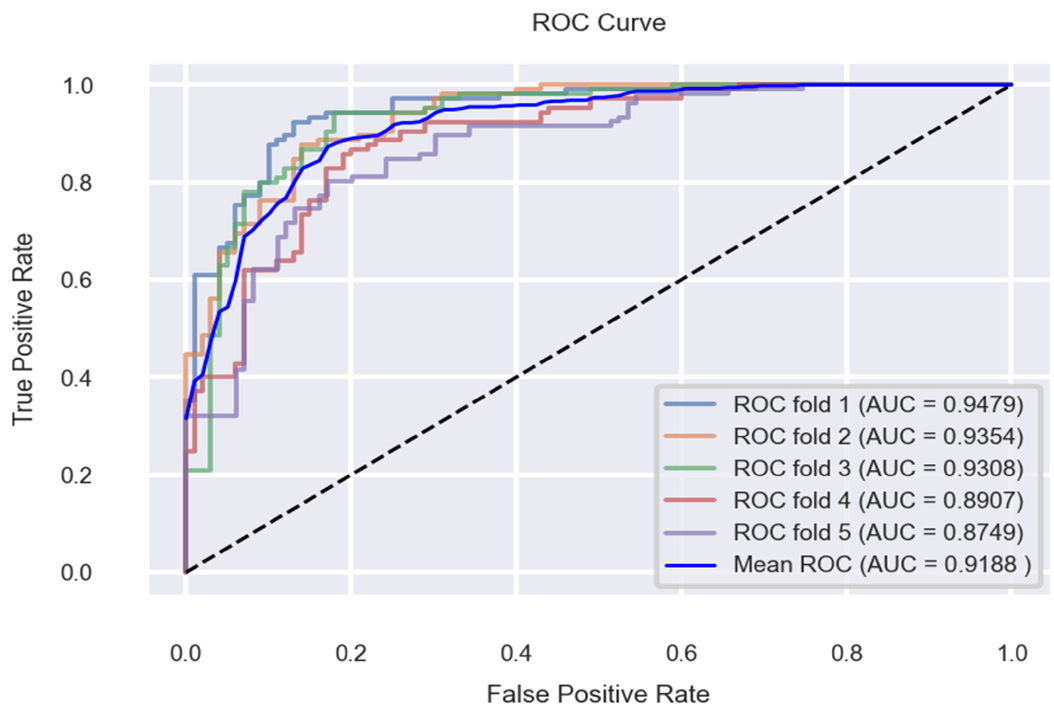
Figure 23. Stratified (K = 5)-Fold Cross-validation Results for Logistic Regression (ROC-AUC).